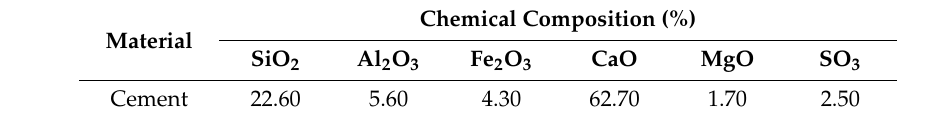
Table 2. The chemical composition of cement.